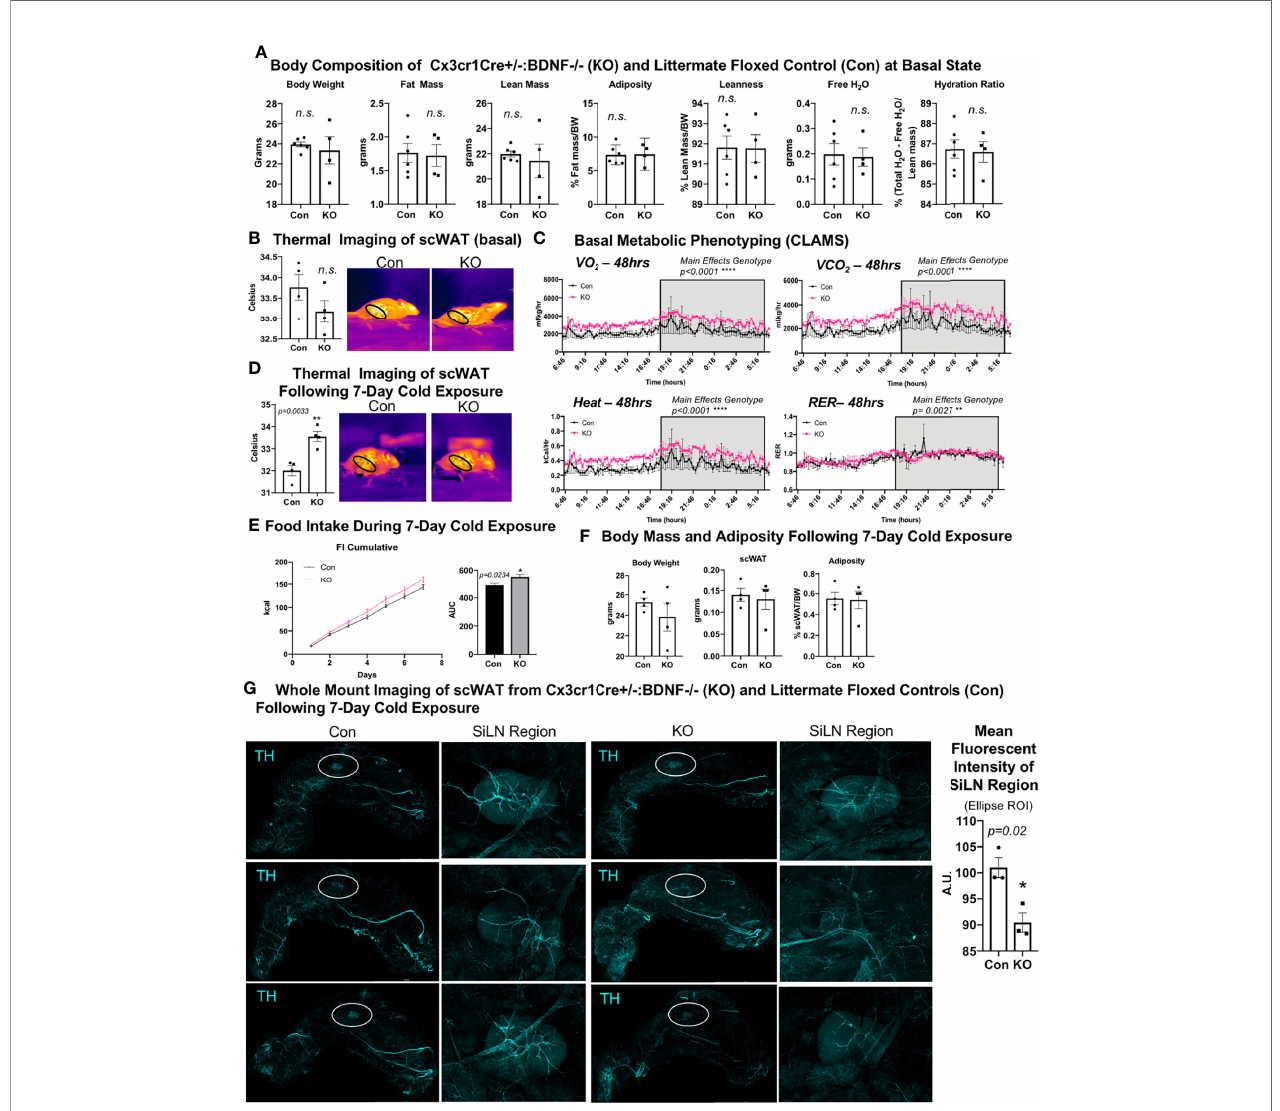
FIGURE 5 | Cx3crCreER1 +/- ::BDNF -/- (KO) mice showed no difference in body composition and had a lower energy expenditure at the basal state and decreased neurite density in scWAT upon cold exposure. (A) The body composition of adult (14 – 16 weeks old) male Cx3cr1CreER +/- :: BDNF -/- (KO) and their littermate Cx3cr1CrERe -/- ::BDNF fl / fl (Con) controls was measured by echoMRI; N = 6 Con, N = 4 KO. (B) The skin surface temperature above the inguinal scWAT of adult (14 weeks old) Con and KO mice at the basal state was measured using a thermal camera (FLIR T560); N = 4 Con, N = 4 KO. The mean temperature in the region of interest (indicated by the black circle on the thermal images) for n = 3 images per animal was quali fi ed in FLIR Research Studio Application software, plotted in GraphPad Prism software, and analyzed by Student ’ s t -test (two-tailed). (C) Adult (25 – 27 weeks old) male Con ( N = 3) and KO ( N = 3) mice were assessed in metabolic cages (CLAMS) at the basal state. The KO mice displayed higher oxygen consumption (VO 2 , top left panel) and carbon dioxide respiration (VCO 2, top right panel); greater energy expenditure was represented as heat calculated from measures of VO 2 and VCO 2 (bottom left panel) and had a signi fi cantly altered respiratory exchange ratio (bottom right panel) compared with Con animals. Waveform analysis of metabolic cage measurements taken at 15-min increments for 48 h and represented over a 24-h period. Two-way ANOVA was performed, and the main effects were reported; p ≤ 0.0001. Time of day is indicated on the x-axis. The animals were maintained on a 12-h light/dark cycle (the gray box indicates the dark cycle). (D) Adult (14 – 16 weeks old) Con ( N = 4) and KO ( N = 4) male mice were cold-exposed at 5°C for 7 days. The skin surface temperature above the inguinal scWAT of adult (14 – 16 weeks old) Con and KO mice was measured at day 7 of cold exposure and analyzed as described in (B) . (E) Adult (14 – 16 weeks old) Con ( N = 4) and KO ( N = 4) male mice were cold-exposed at 5°C for 7 days. Food intake was measured daily throughout the cold exposure intervention. The area under the curve for cumulative food intake was calculated and compared for Con and KO animals. (F) The body mass and tissue weights were measured, and adiposity was calculated for cold-exposed Con ( N = 4) and KO ( N = 4) mice. Data were analyzed by Student ’ s t -test (two-tailed). All cold-exposed mice were single-caged in a diurnal incubator (12-h light/dark cycle). (G) Whole-mount immunostaining and imaging were performed on scWAT from cold-exposed Con and KO male mice. Tissue was stained with tyrosine hydroxylase for the assessment of sympathetic innervation. Imaging was performed on a confocal microscope equipped with WLL using an objective at ×10 magni fi cation. Images are z-maximum intensity projections (with median blur fi lter and 4 kernel size applied) of merged tiled z-stack imaging of the entire scWAT depot. White circles represent the SiLN region (inset to the right of each image) for which the mean intensity was quanti fi ed. All error bars are SEMs. *p-value < 0.05; **p-value < 0.01, ****p-value < 0.0001; n.s., not signi fi